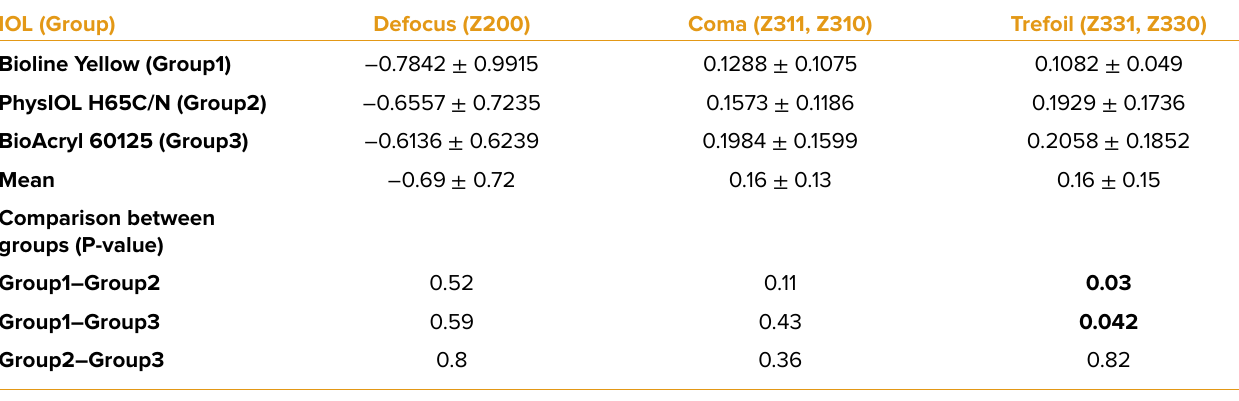
Table 3. Comparisons of second- and third-order aberrations among the three IOL groups IOL (Group)